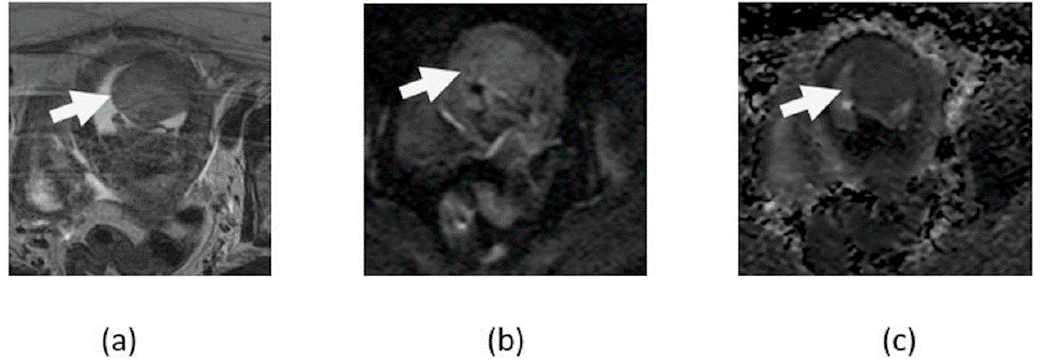
Figure 2. Axial T2-weighted ( a ), DWI ( b ), and ADC map ( c ) image of the pelvis shows T2 intermediate signal submucosal fundal lesion showing restricted diffusion characterized by a high signal on DWI and low signal on ADC map, pathologically proven cellular leiomyoma (arrows).